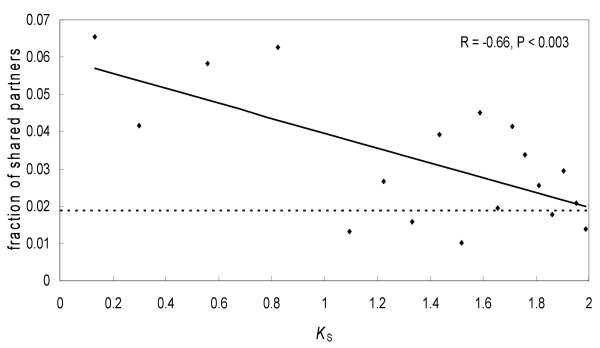
The change in the fraction of shared partners with evolutionary time (measured by KS). Each point represents an average value for 40 duplicate gene pairs. Dashed line indicates the fraction of shared partners averaged among 1000 randomly selected pairs of singletons (random selection process was repeated 1000 times).